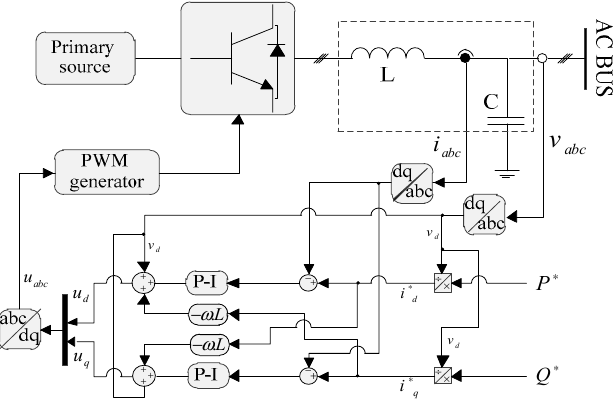
Figure 3. Structure of a grid-following converter control system.